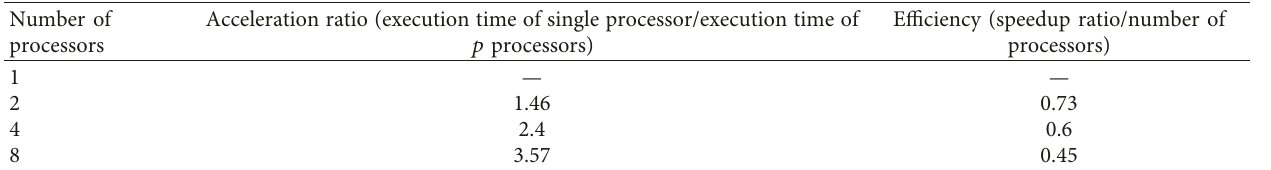
Table 3: Comparison of execution efficiency of processors with different